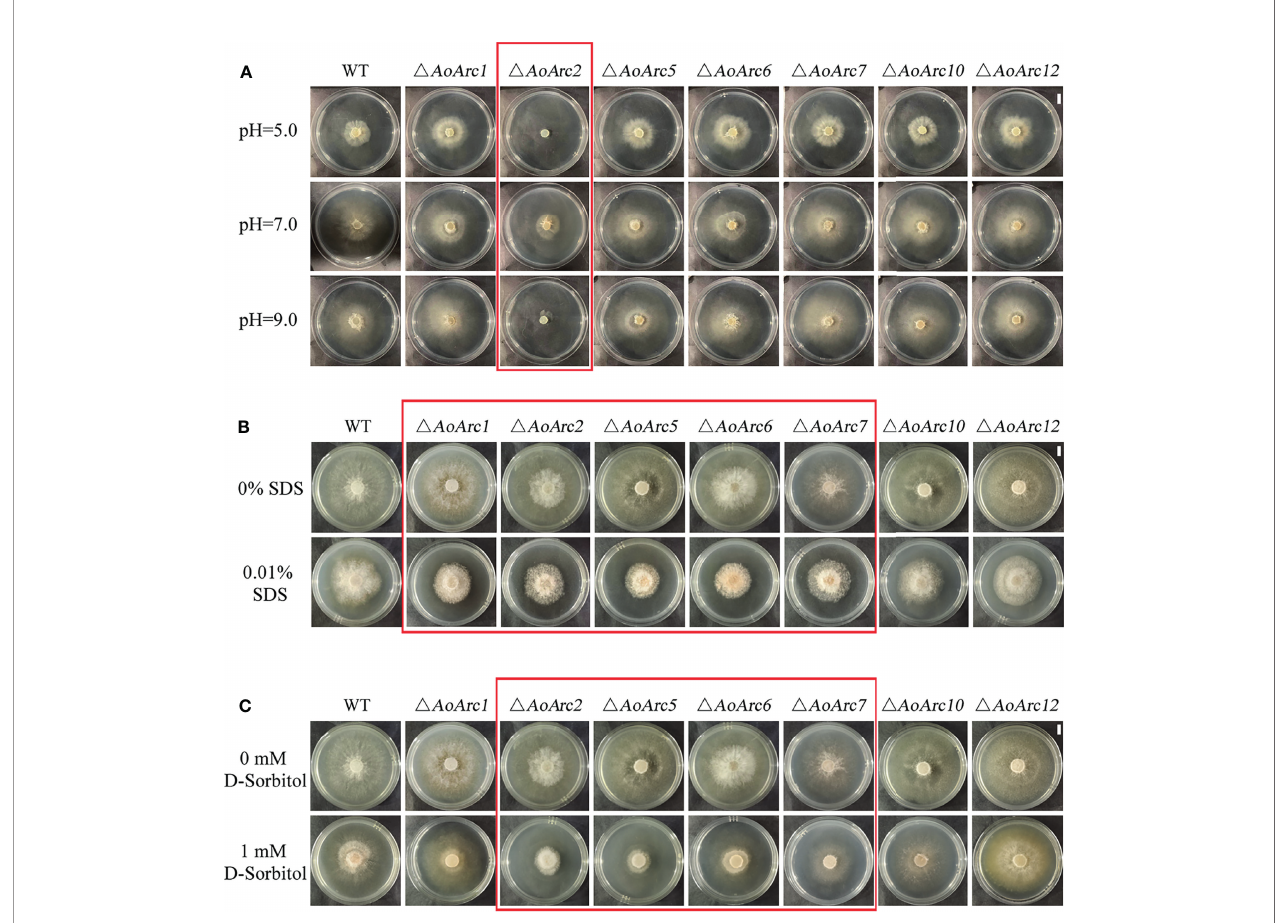
FIGURE 7 | Arrestin responds to stress stimulation. (A) Under different pH conditions, comparison of the growth of WT and mutant strains on TG medium. (B) Colonial morphology of fungal strains under cell wall-interfering agent stress. (C) Colonial morphology of fungal strains under osmotic stress. Bar: 1 cm. Red box: strains with obvious difference